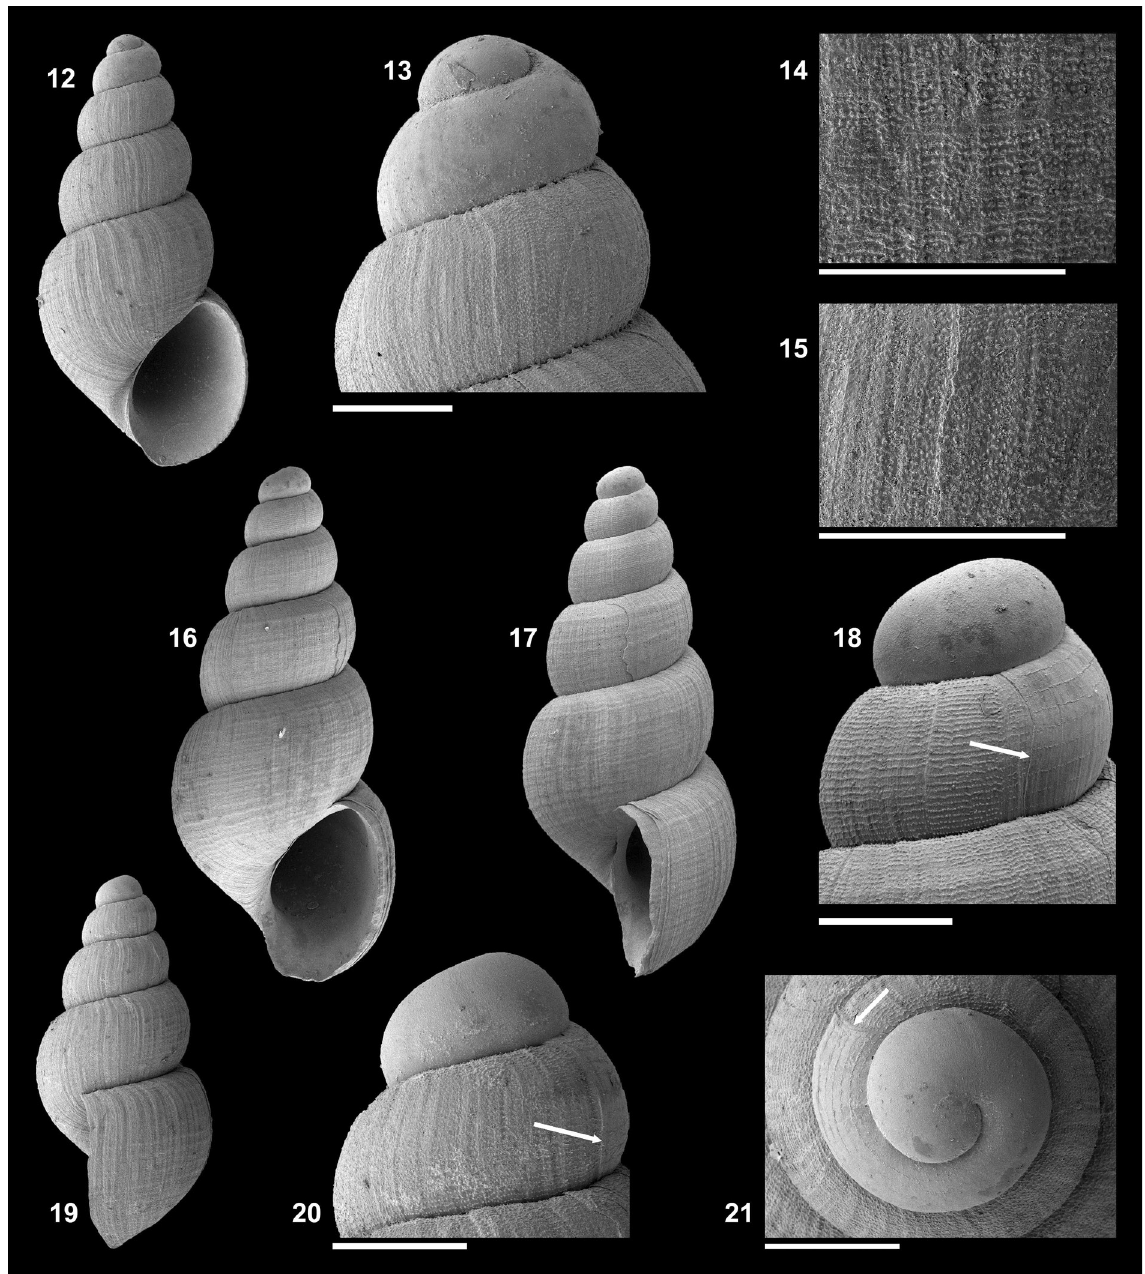
Figs 12–21. Talassia sandersoni (A.E. Verril, 1884), USA, off Cape Lookout, TRACOS2010-32. 12– 15 . Subadult shell, H = 2.4 mm, W = 1.1 mm, Ha = 0.9 mm, apical angle = 32°. 12 . Ventral view. 13 . Protoconch, Wp = 0.38 mm. 14 . Sculpture first whorl. 15 . Sculpture body whorl. 16–18 . Adult shell, H = 3.0 mm, W = 1.3 mm, Ha = 1.0 mm, apical angle = 28°. 16 . Ventral view. 17 . Side view. 18 . Protoconch, Wp = 0.38 mm, arrow at lip. 19–22 . Subadult shell, H = 2.2 mm, Ha = 0.9 mm. 19 . Side view. 20–21 . Protoconch, Wp = 0.38 mm. Scale bars = 0.2